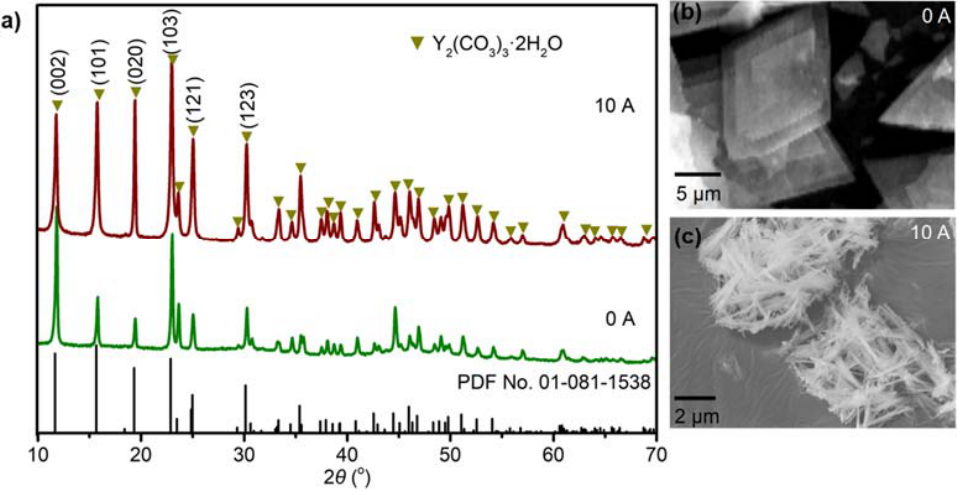
Figure 4. ( a ) XRD patterns and ( b , c ) SEM images of yttria precursor with and without the application of an electric fi eld.